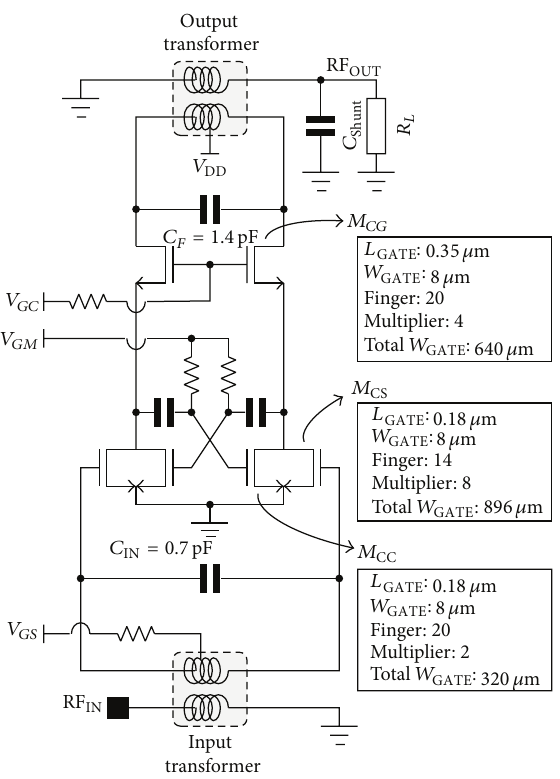
Figure 5: Schematic of the proposed power amplifier.